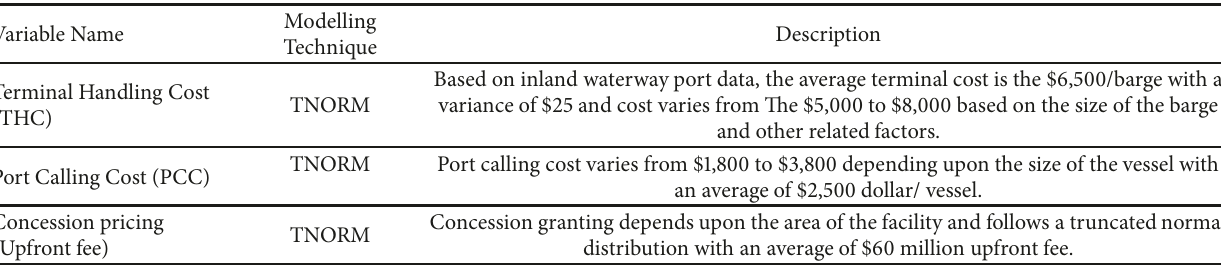
Table 5: Modelling of variables contributed to port pricing.